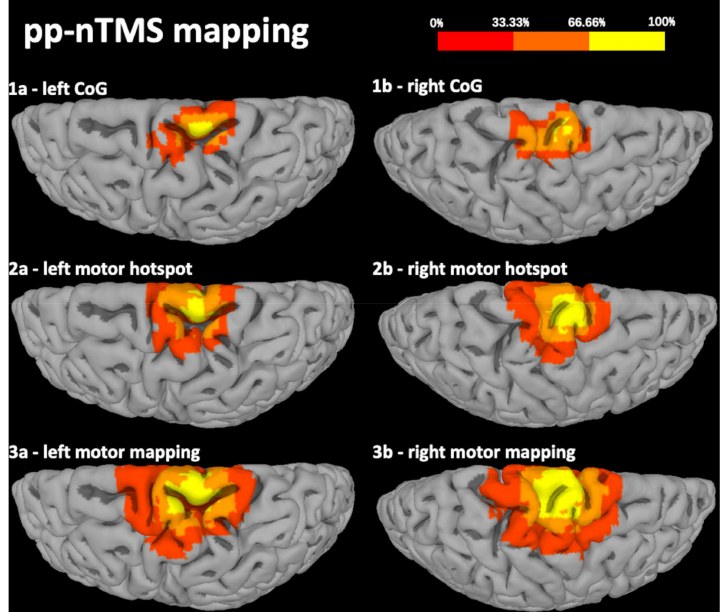
Figure 2. Heat map of the distribution of the center of gravity (CoG), motor hotspot, and total extent of the motor map for paired-pulse navigated transcranial magnetic stimulation (pp-nTMS). This figure shows a heat map of the spatial distribution of the CoG location ( 1a , 1b ), motor hotspot ( 2a , 2b ), and extent of the motor map ( 3a , 3b ) of lower extremity (lE) muscle representations, projected onto a brain template after transformation of coordinates into standard space. Results are derived from motor mapping using pp-nTMS with biphasic pulses. The color coding represents the proportion of patients